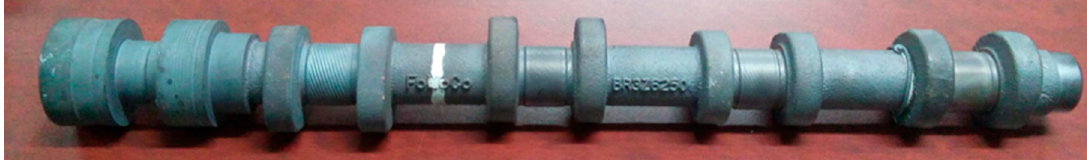
Figure 1. As-cast camshaft containing 8 lobes.